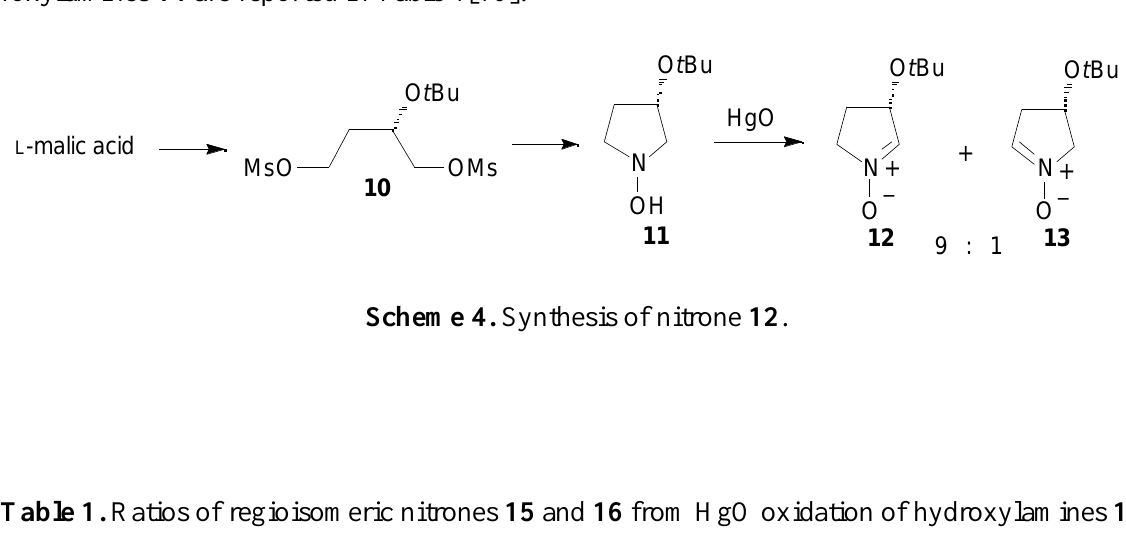
Table 1. Ratios of regioisomeric nitrones 15 and 16 from HgO oxidation of hydroxylamines 14 .